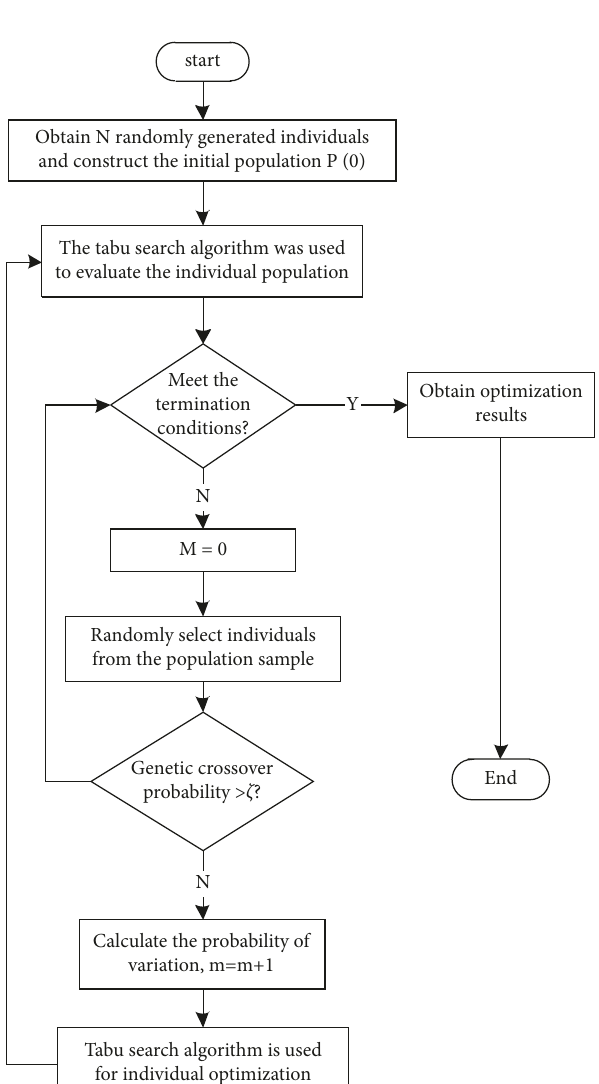
Figure 3: Flow chart of mixed genetic tabu search algorithm.